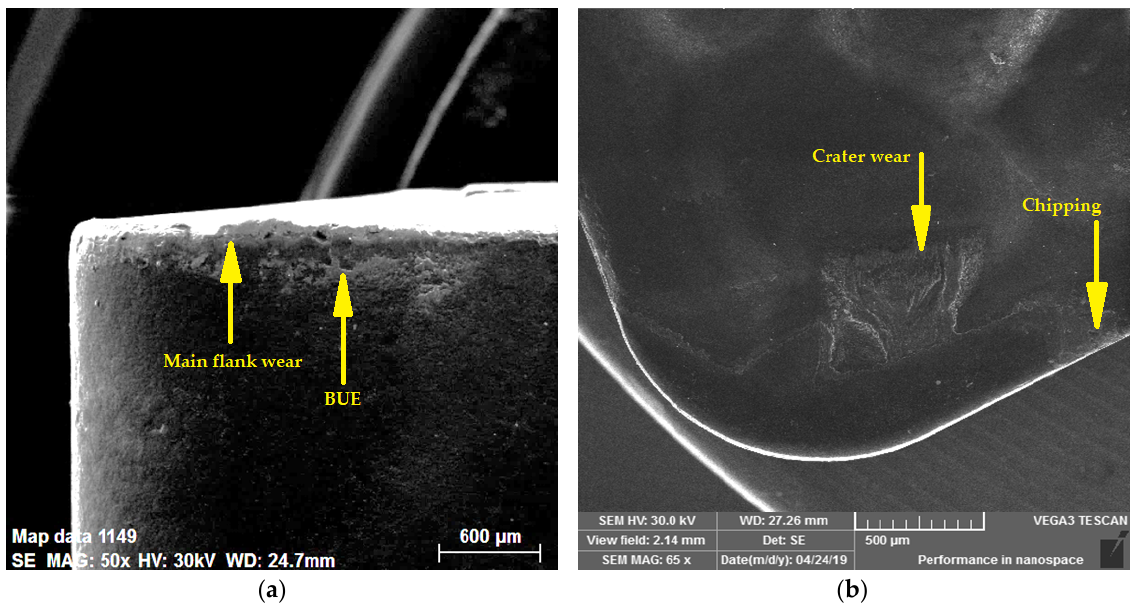
Figure 11. SEM analysis of wear of CNMG 120408-MP3 WPP10S: ( a ) main flank view, ( b ) rake face. Mapping of elements on the worn flank of CNMG 120408-MP3 WPP10S confirms the adhered machined material, see Figure 12. Wear under the blade has reached the level of the TiC coating layer.